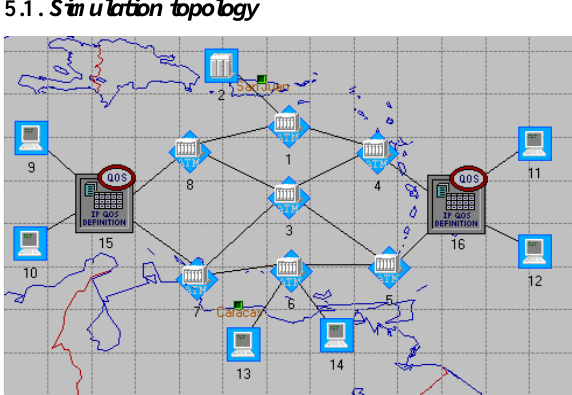
Fig. 7. The simulation network topology.